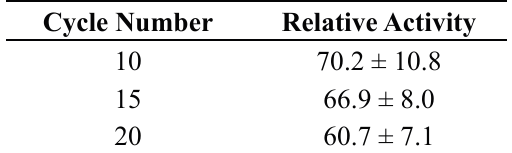
Table 1. Reusability of immobilized PA27 after 20